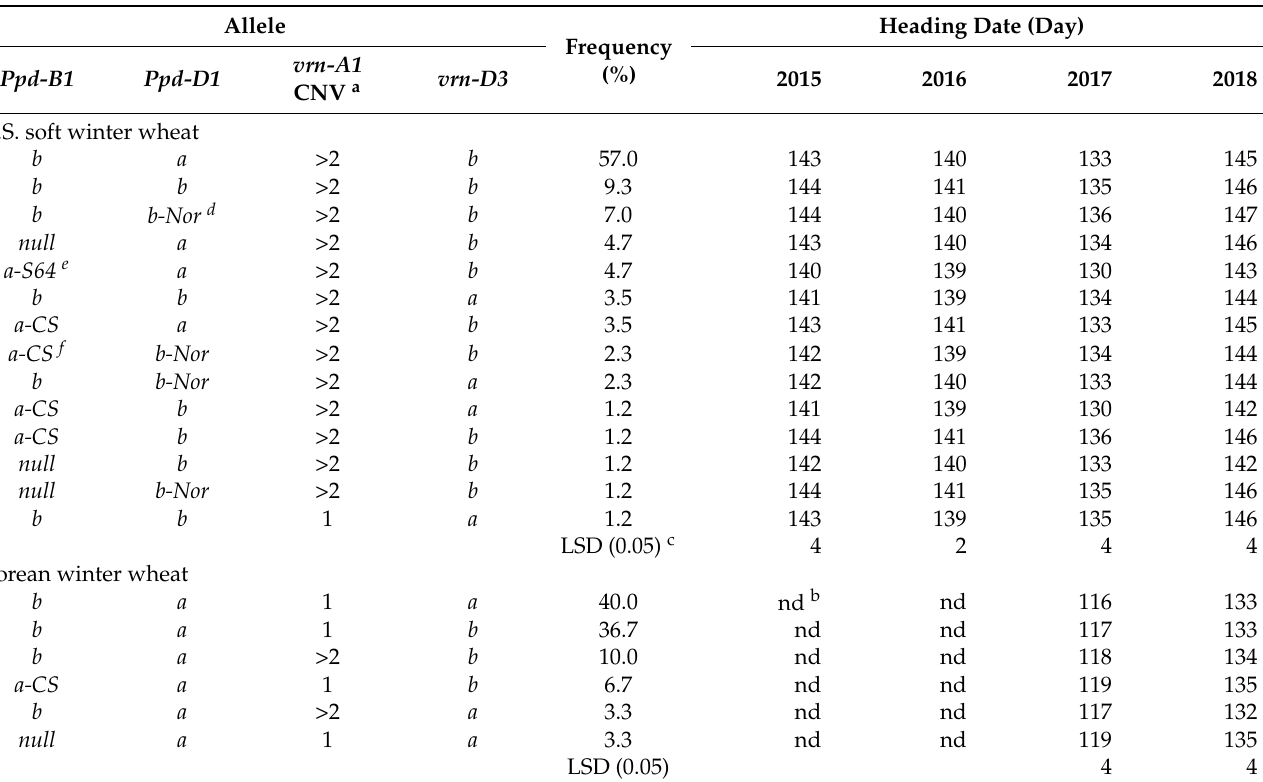
Table 4. Phenology gene profiles of 86 eastern U.S. soft winter wheat genotypes and 30 Korean winter wheat varieties carrying homozygous alleles at the Ppd-B1 , Ppd-D1 , Vrn-A1 and Vrn-D3 genes sorted by frequency and their heading